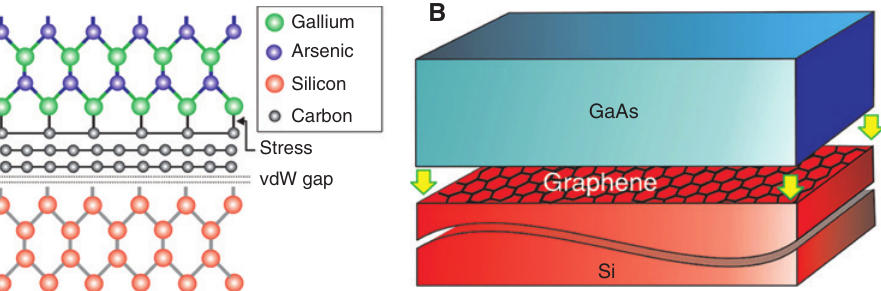
Figure 2: (A) Atomic diagram of the GaAs/multilayer graphene/silicon layers. (B) Visual representation showing the stacking of the GaAs/ graphene/silicon layers [6].